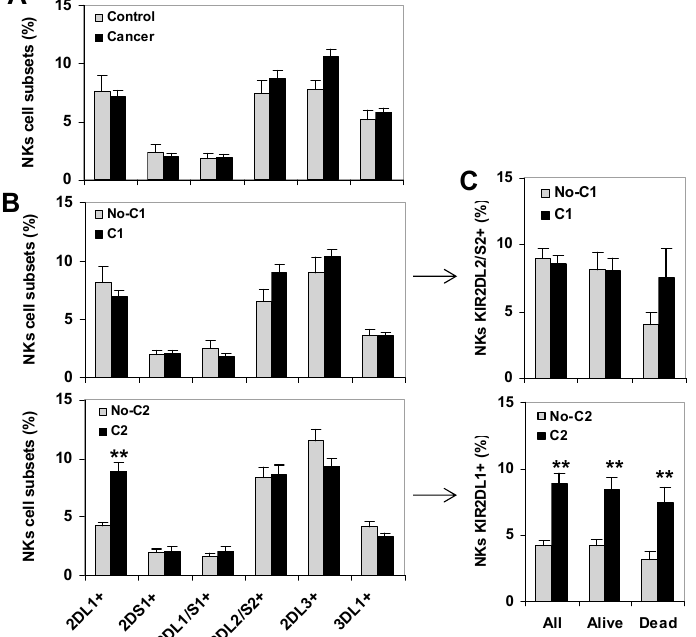
Figure 3. KIR + NK cell repertoire in healthy controls and cancer patients. ( A ) Frequency of KIR + NK cells in peripheral blood of healthy controls ( n = 42) and cancer patients (80 melanomas, 80 bladder cancers and 89 ovarian cancers). ( B ) Frequency of KIR + NK cell subsets in cancer patients according to the presence of the HLA C1- and C2-ligands, respectively. ** p < 0.01, comparing KIR2DL1 + NK cells in HLA-C2 positive (C1C2 or C2C2) and negative (C1C1) cancer patients. ( C ) Frequency of KIR2DL2 / S2 + and KIR2DL1 + NK cells in all patients ( n = 249), patients who survived.